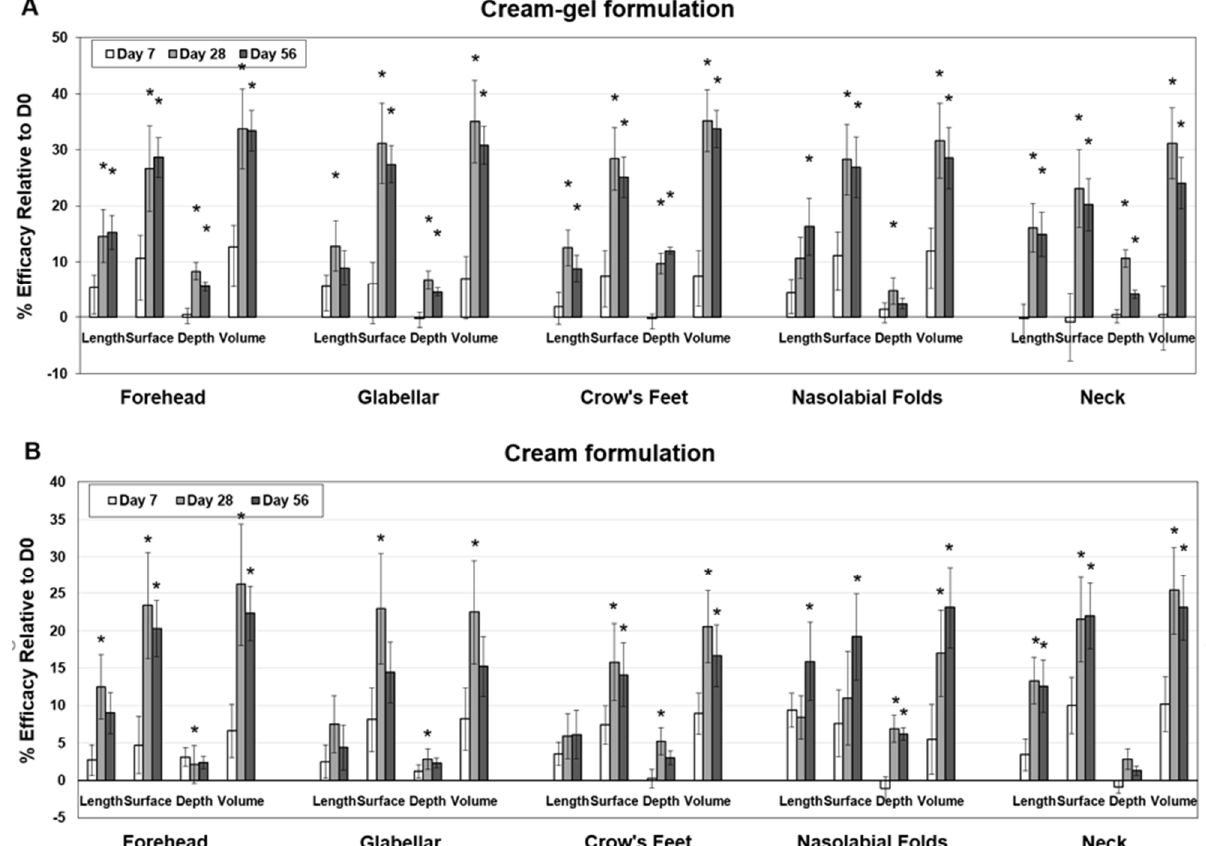
Figure 1. Quantification of wrinkle dimensions following topical treatment of products over 56 days in human subjects. Twice daily, subjects applied ( A ) a cream-gel or ( B ) a cream formulation. The data presented represent efficacy relative to D0 in % ± SEM in treated subjects. Statistical comparisons of mean values to D0 by a univariate analysis of variance with two factors followed by a Dunnett test (* p < 0.05).